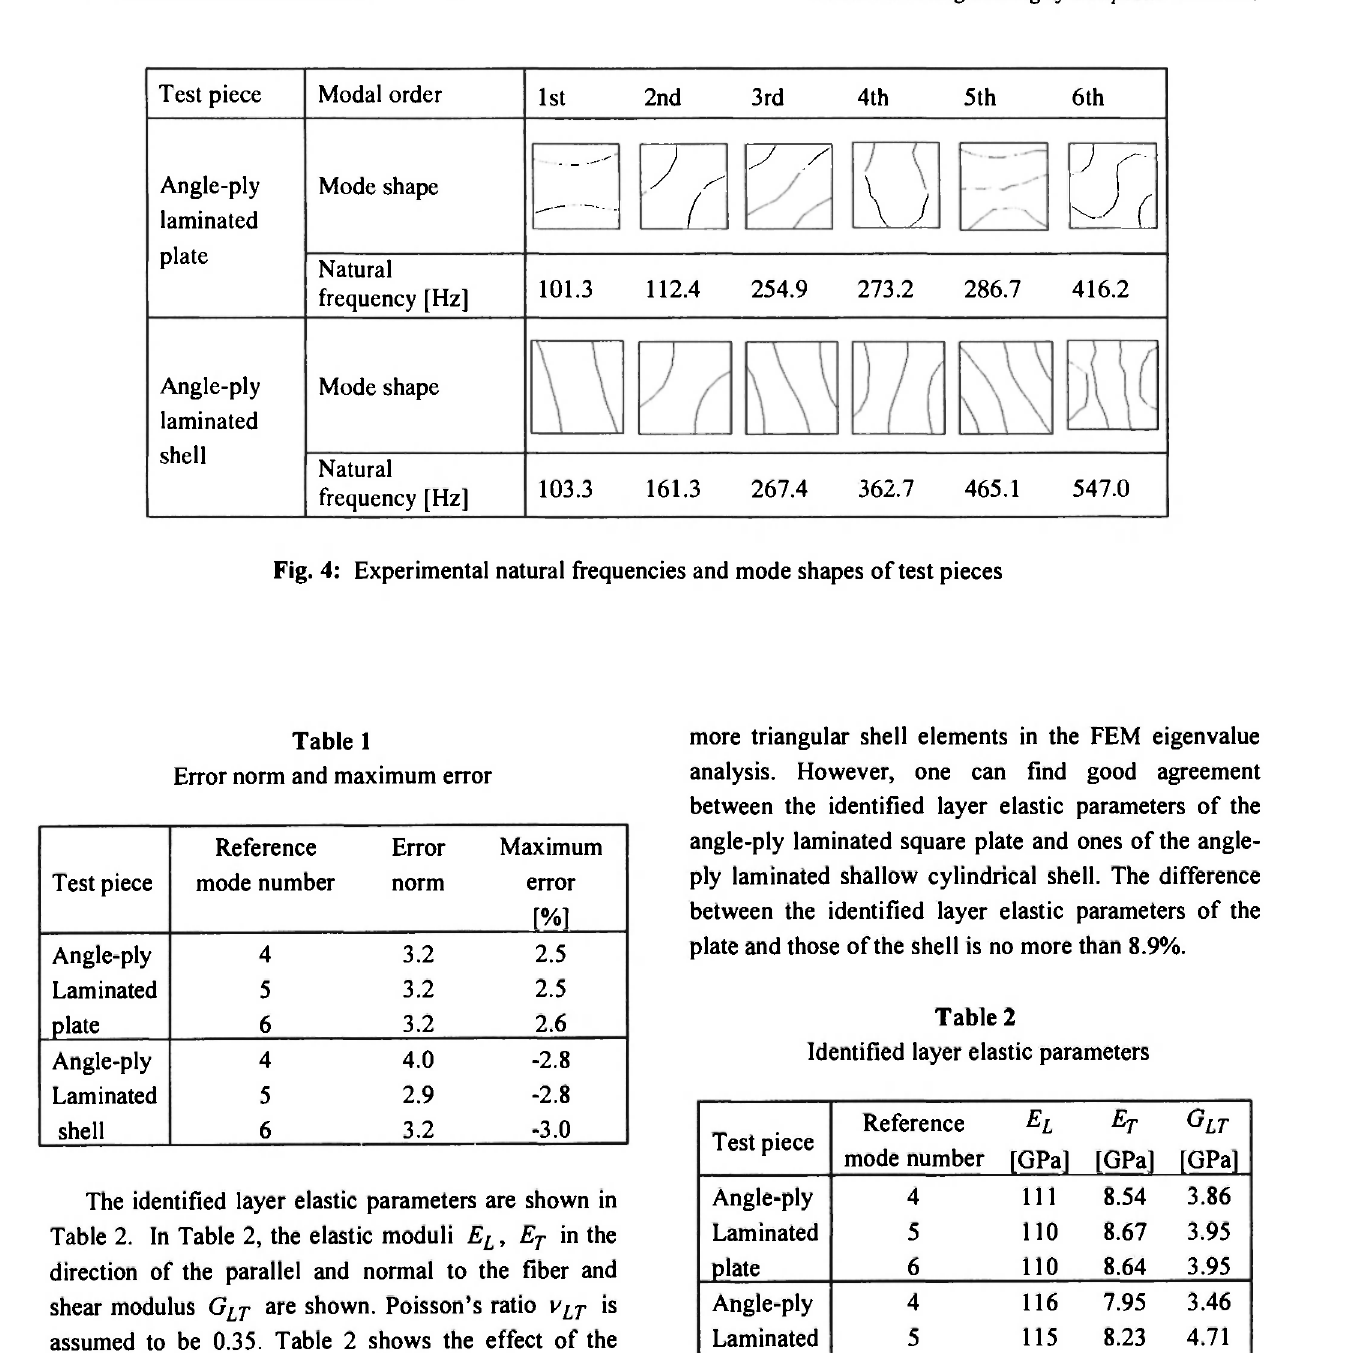
more triangular shell elements in the FEM eigenvalue analysis. However, one can find good agreement between the identified layer elastic parameters of the angle-ply laminated square plate and ones of the angle- ply laminated shallow cylindrical shell. The difference between the identified layer elastic parameters of the plate and those of the shell is no more than